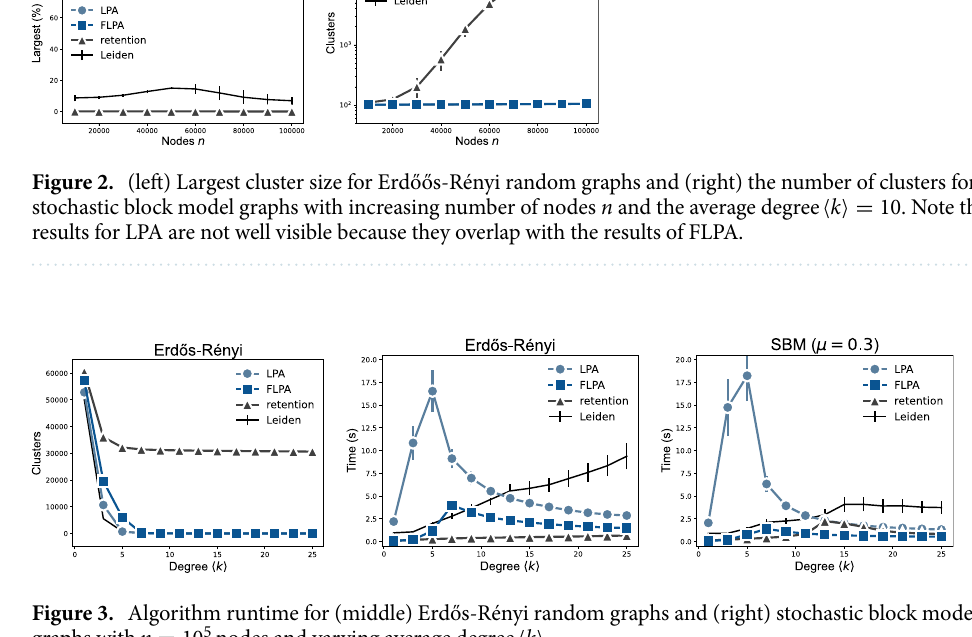
Figure 3. Algorithm runtime for (middle) Erdős-Rényi random graphs and (right) stochastic block model graphs with n = 10 5 nodes and varying average degree (cid:31) k (cid:30)